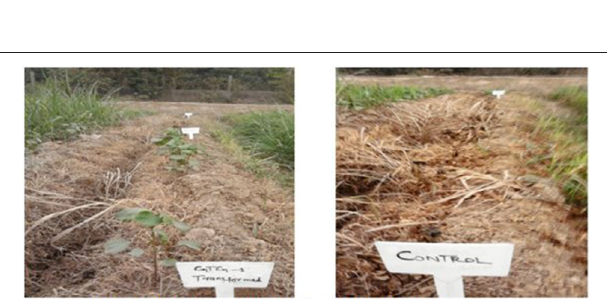
FIGURE 11 | Glyphosate spray assay of transgenic and control cotton plants.